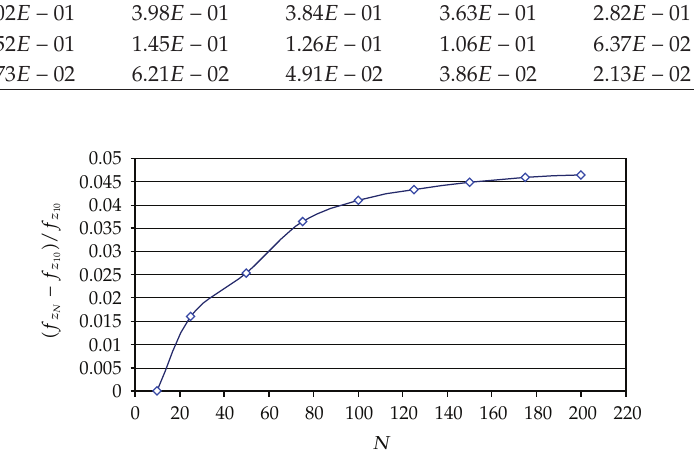
− f z 10 /f z 10 versus N element terms. N